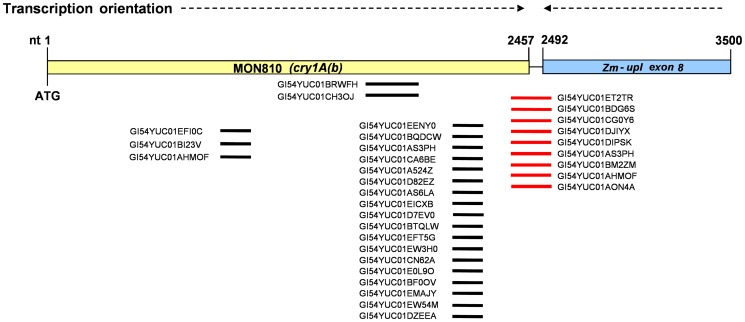
mRNA-seq reads matching the cry1A(b) transgene coding sequence, mapped over a schematic representation of the 3' region of the MON810 transgene locus.The inserted cry1A(b) transgene, in antisense orientation, truncates exon 8 of the HECT-E3 ubiquitin ligase (zm-upl) host gene. Polyadenylated reads are shown in red.